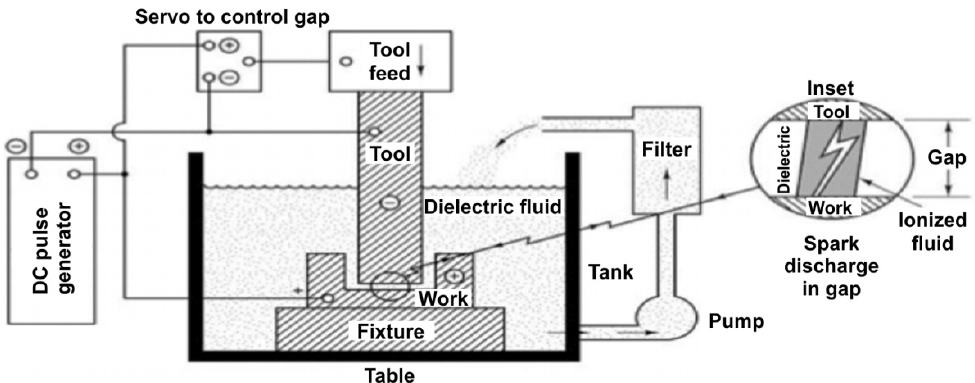
Figure 6. Schematic of electric discharge machining (EDM) (Reprinted with permission from Ref. [105]. 2019, copyright Nature Switzerland AG).